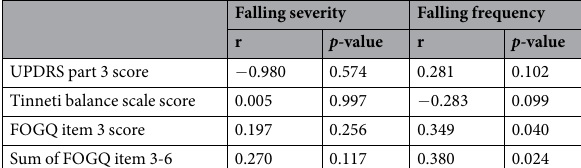
Falling severity Falling frequency r p -value r p -value